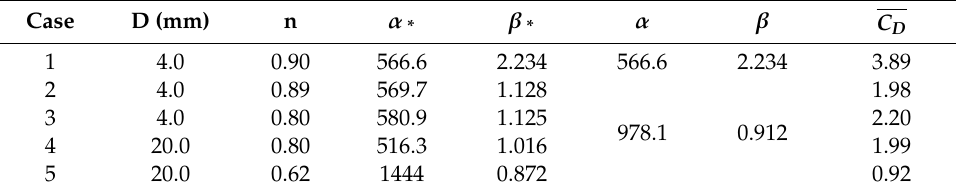
Table 4. α and β value from linear relation between f v and Re / ( 1 − n ) .